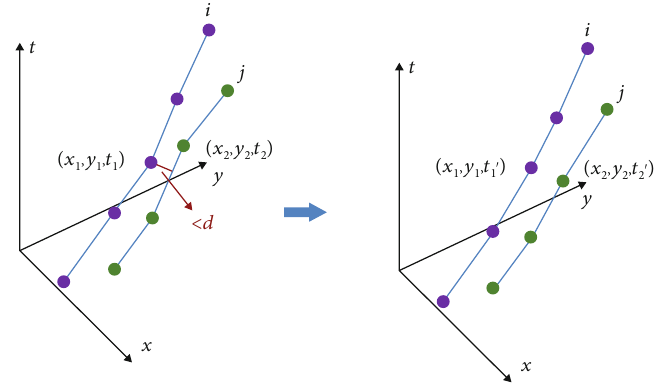
Figure 7: The time of collision